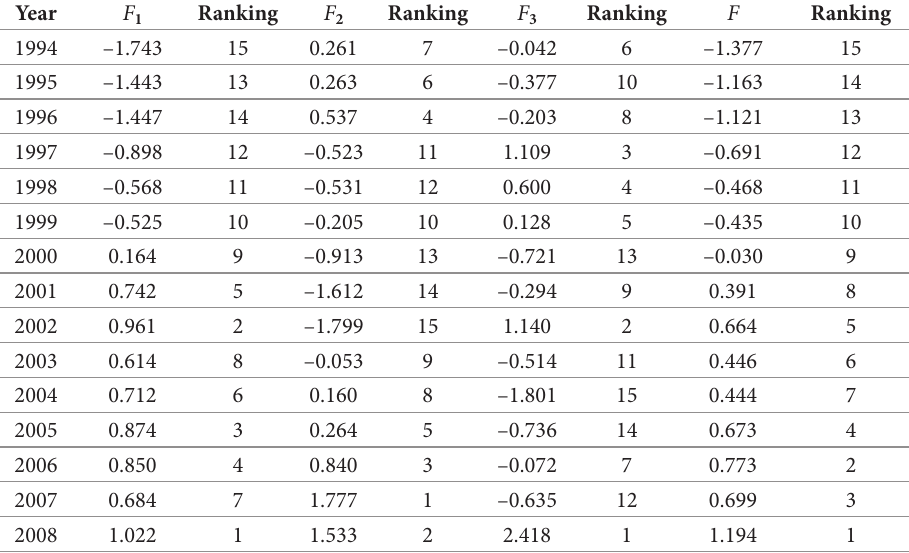
Table 7. Component Scores of Innovation Capability of Qingdao Science